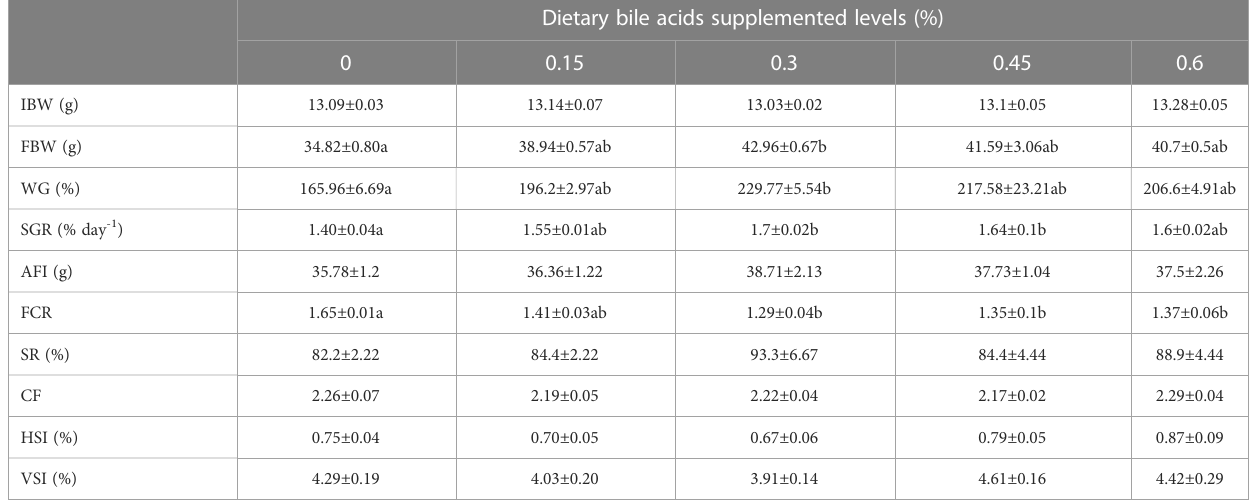
TABLE 3 Growth performance, feed utilization and morphological indexes of coral trout fed the experimental diets for 10 weeks. Dietary bile acids supplemented levels (%)